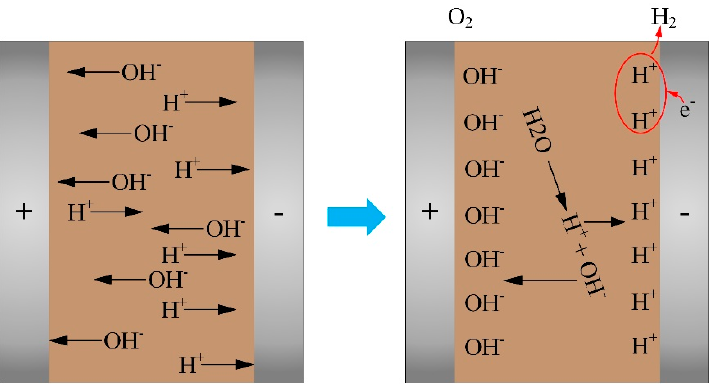
Figure 8. Schematic of the generation and accumulation of H + /OH − ions within the pressboard.